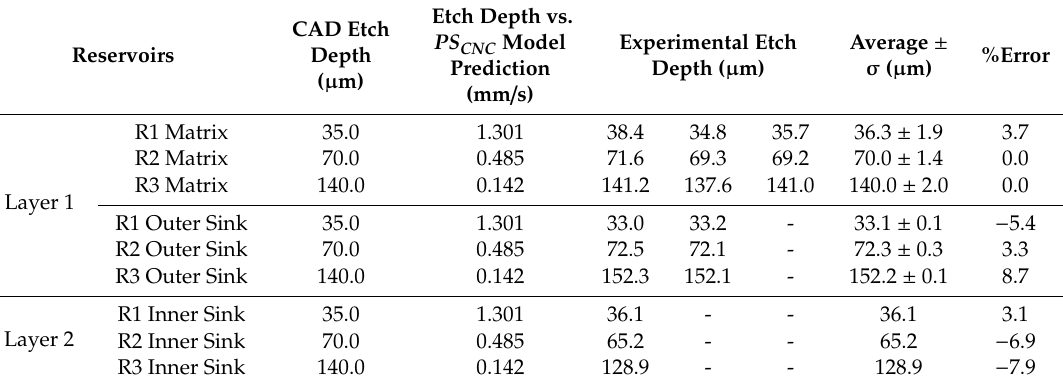
Table 2. Surface profilometer depth characterization of the 3D multi-depth reservoir micromodel machined into borosilicate glass substrate using FLMP. The experimental machined etch depths are compared to model predictions. The depths of layer 2 are relative to the etched surface of layer 1. NB: (-) % error indicates that the machined etch depth value was < values predicted by the calibration